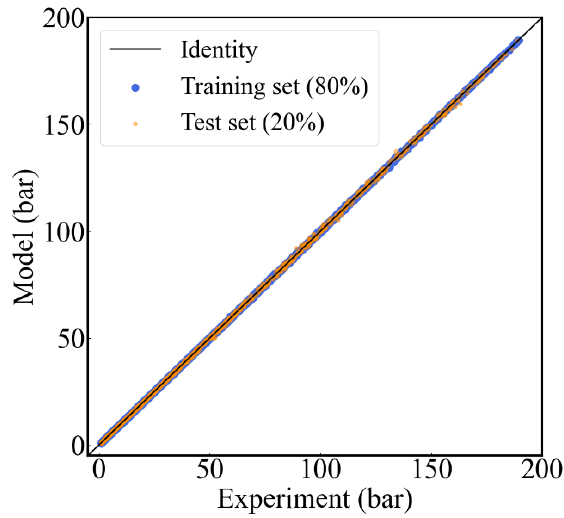
Figure 7. Regression analysis of optimized XGB.